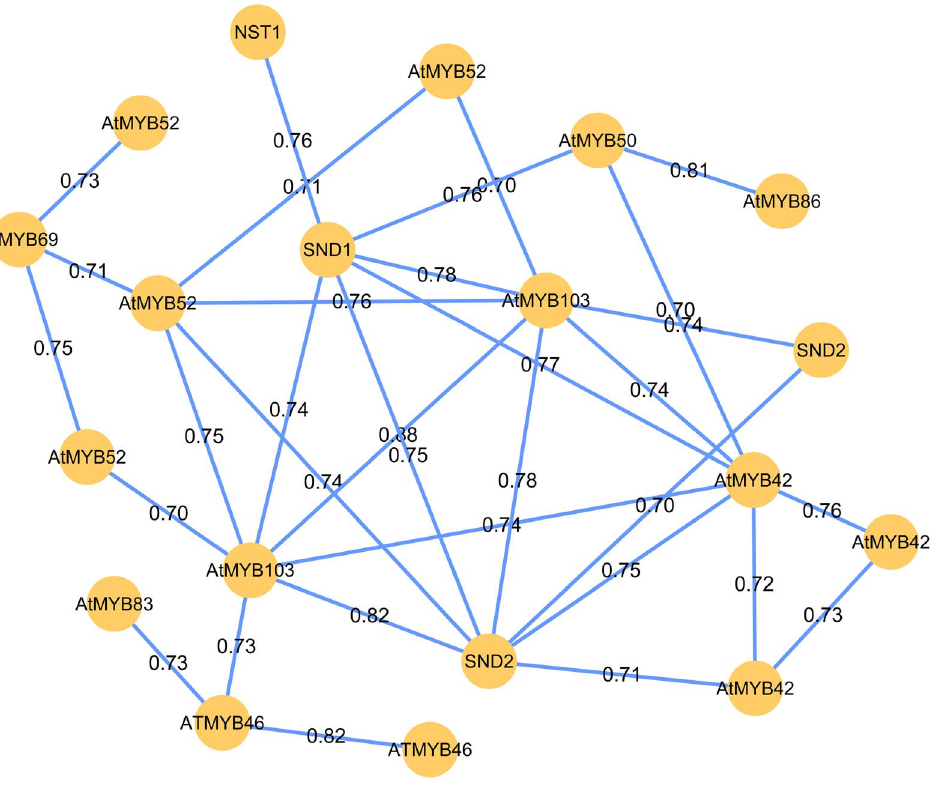
Figure 3. Co-expression relationship between transcription factors (TFs) in Module 4 of PGCN. A node represents a TF gene and an edge indicates a significant co-expression relationship between two genes. The gene name of the Arabidopsis homologous gene is used for each